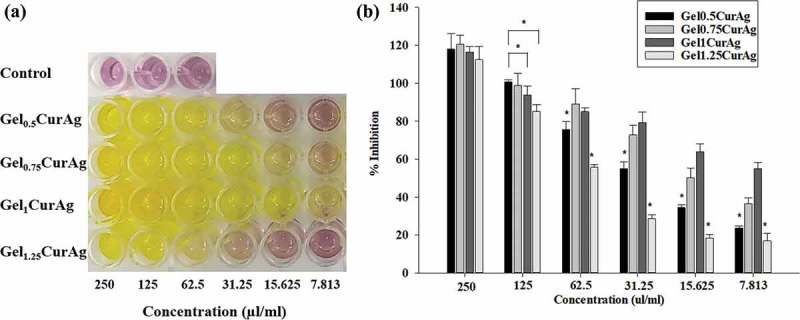
Images of (a) inhibition zone of GelCur and GelCurAg and (b) their measured inhibitory zones against S. aureus and P. aeruginosa.Asterisk (*) indicates p < 0.05 (n = 3).